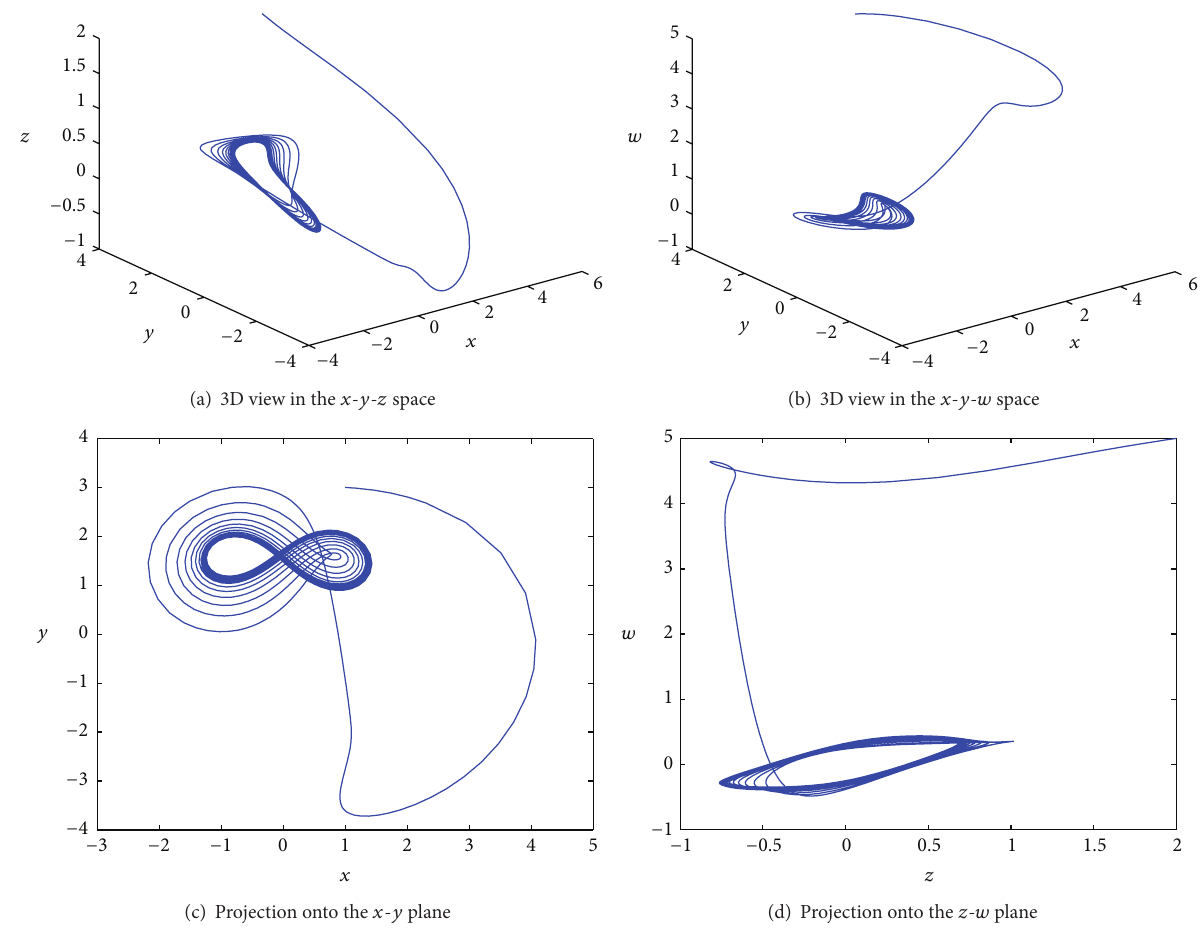
Figure 1: Phase portraits of hyperchaotic finance system